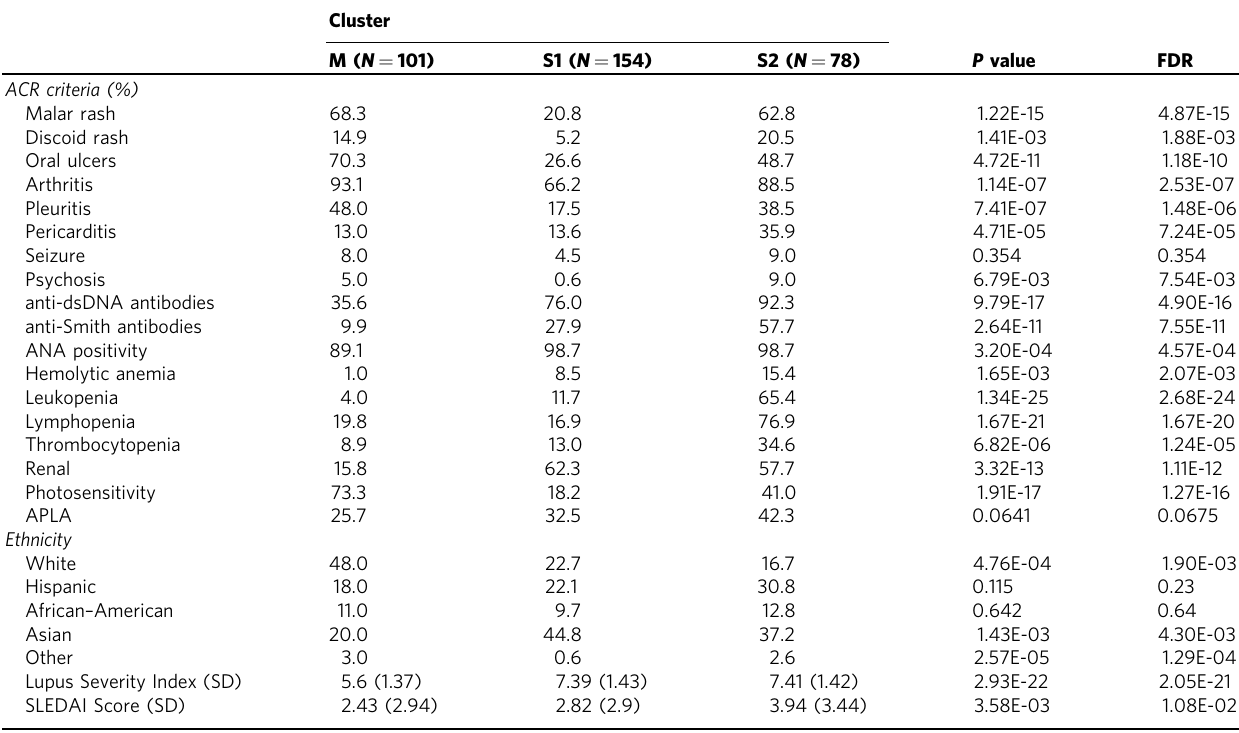
Table 1 Summary of signi fi cant clinical and demographic variables across clusters Cluster M ( N = 101) S1 ( N = 154) S2 ( N = 78) P value